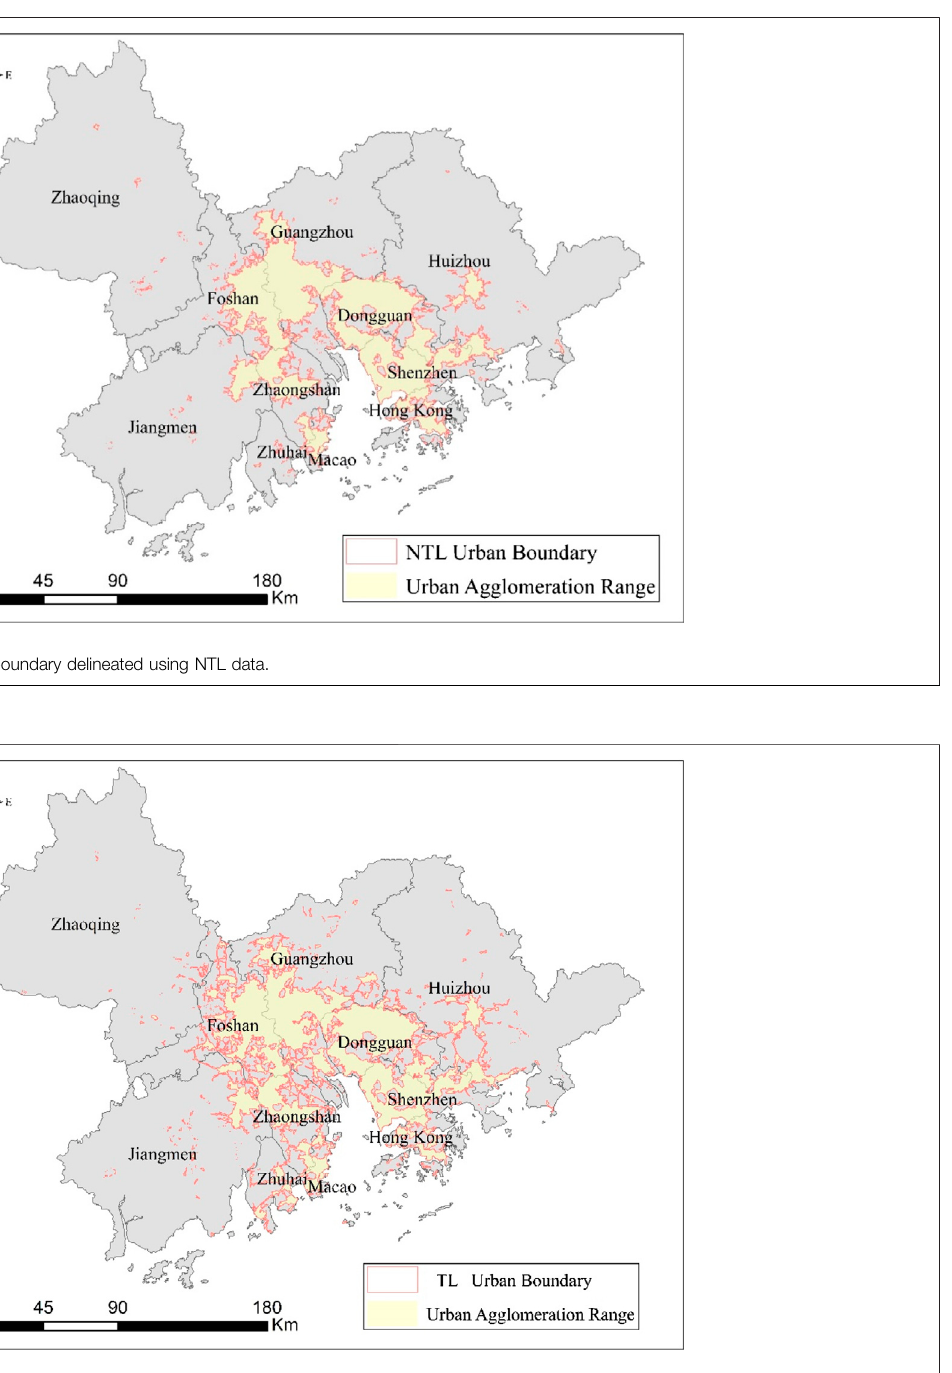
FIGURE 5 | GBA urban agglomeration boundary delineated using TL